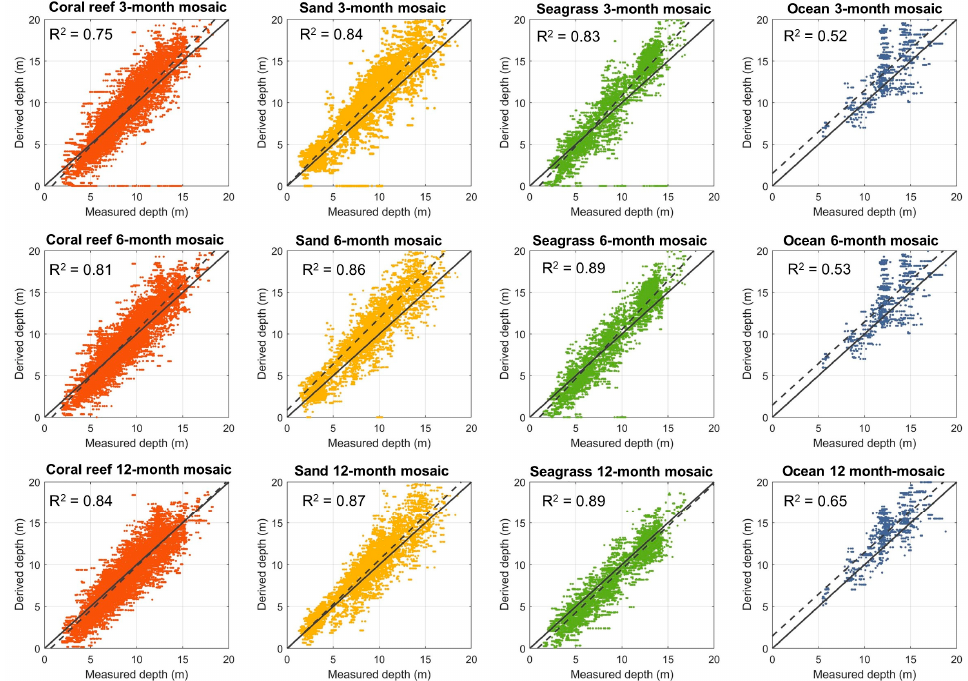
Figure 10. Results performance in coral reef, sand, seagrass and ocean in three different mosaic time frames. The trend line of 12-month mosaic followed the 1:1 line more accurately than the three-month and six-month mosaics.